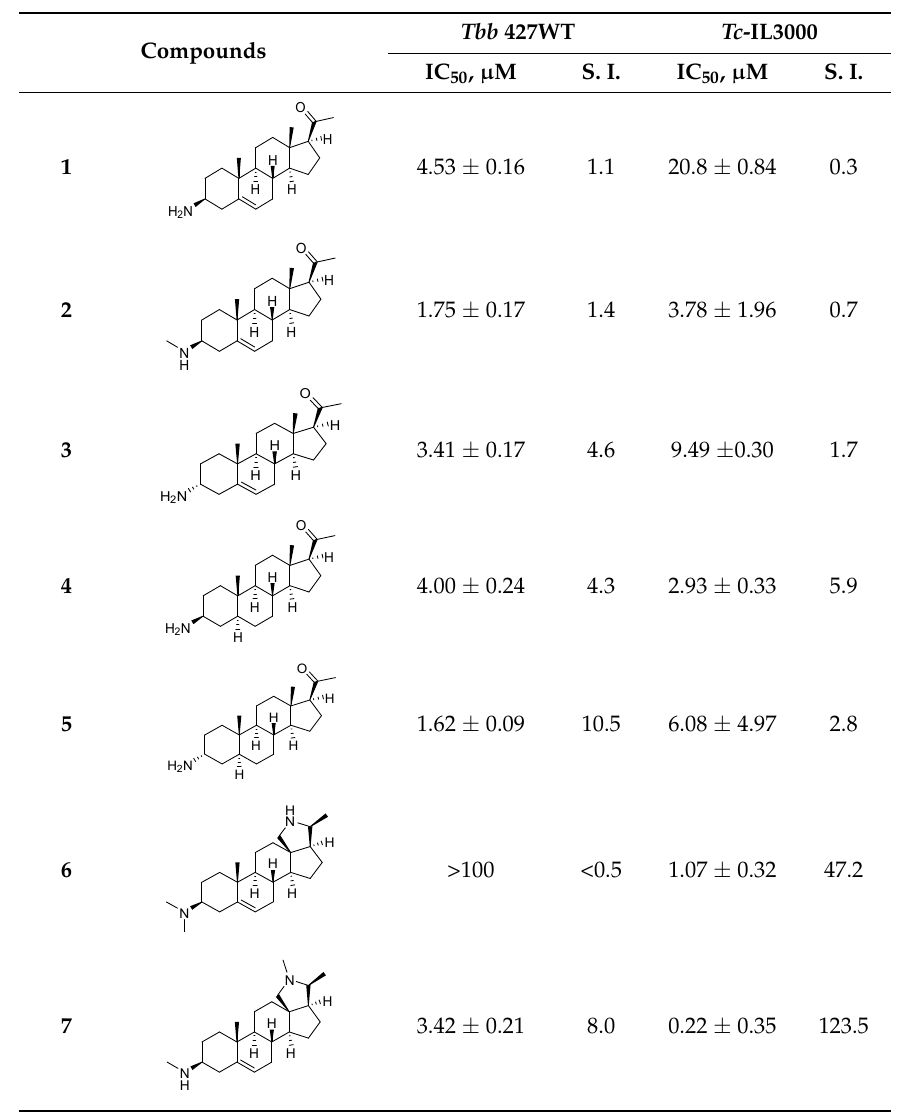
Table 1. In vitro activities of some 3-aminosteroids against wild-type T. b. brucei (Tbb 427WT) and Tc- IL3000.